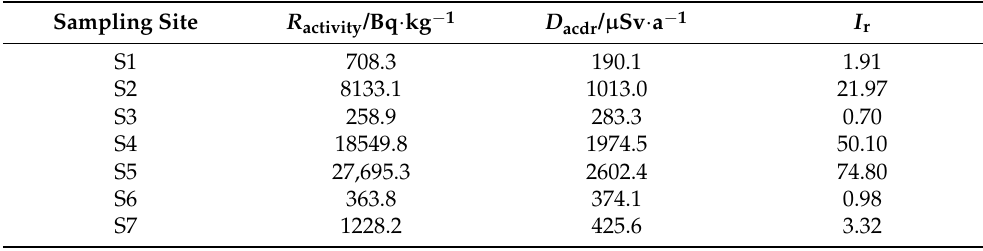
Table 4. The calculated radium equivalent activity R activity , external radiation index I r , and annual effective dose rate D aedr for sampling sites inside the decommissioned REE